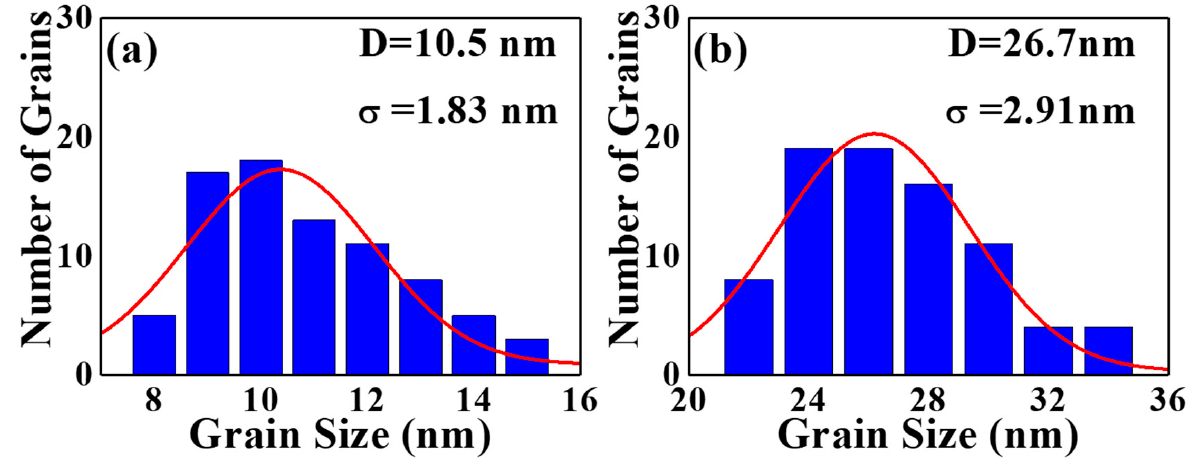
Figure 7. The grain size distribution and fitted average grains size of ( a ) reference sample and ( b ) FePtCAg/MgTiOBN film.